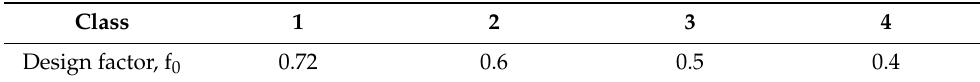
Figure 10. Ratio of yield stress and ultimate strength ratios with and without hydrogen embrittlement versus yield stress. Table 4. Design factor for pipes transporting hydrogen